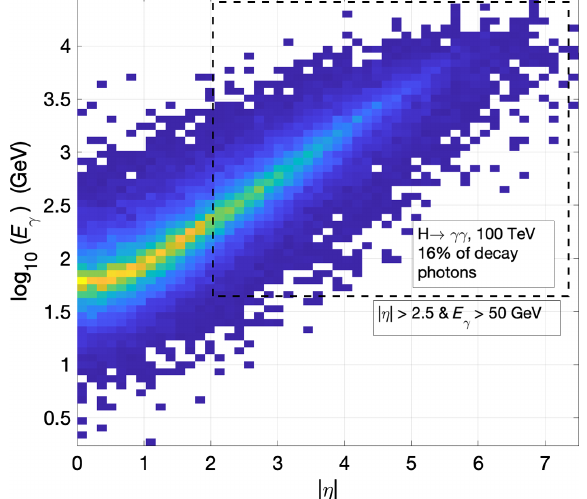
Ronzhin,FIG. 37. Daughter photon energy vs pseudorapidity for H → γγ at 100 TeV. The box indicates the region covered by our baseline timing layer associated with the